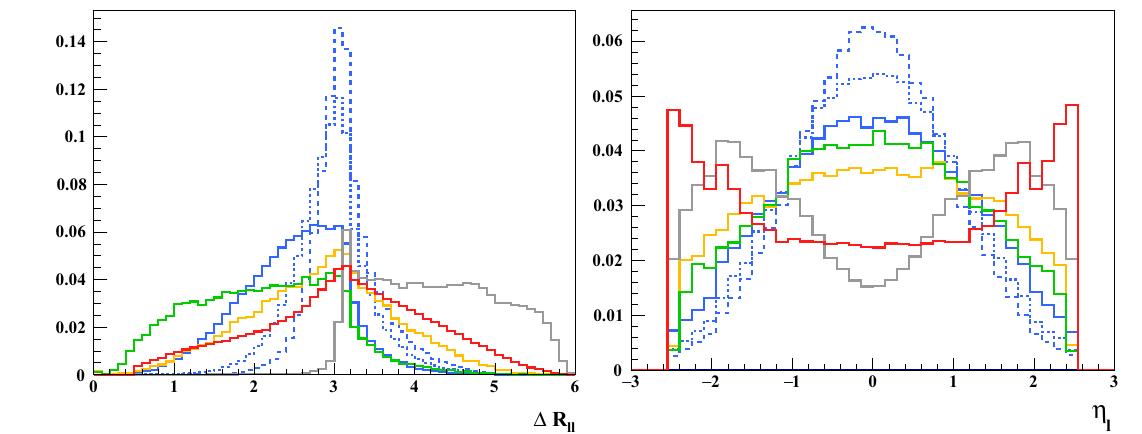
Fig. 6 Normalized kinematic distribution (cid:8) R (cid:2)(cid:2) (left) and η (cid:2) (right) for the signal e + e − → H νν ( H → WW → 2 (cid:2) 2 ν ) with m H = 300 GeV (solid blue), 600 GeV (dotted blue), 900 GeV (dashed blue) and